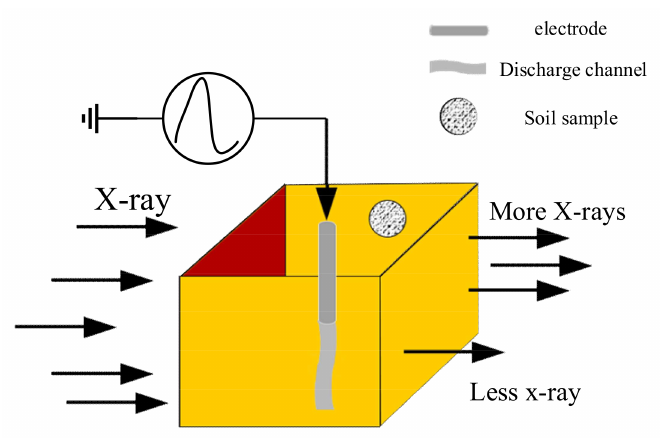
Figure 2. Schematic diagram of X-ray imaging of the soil discharge